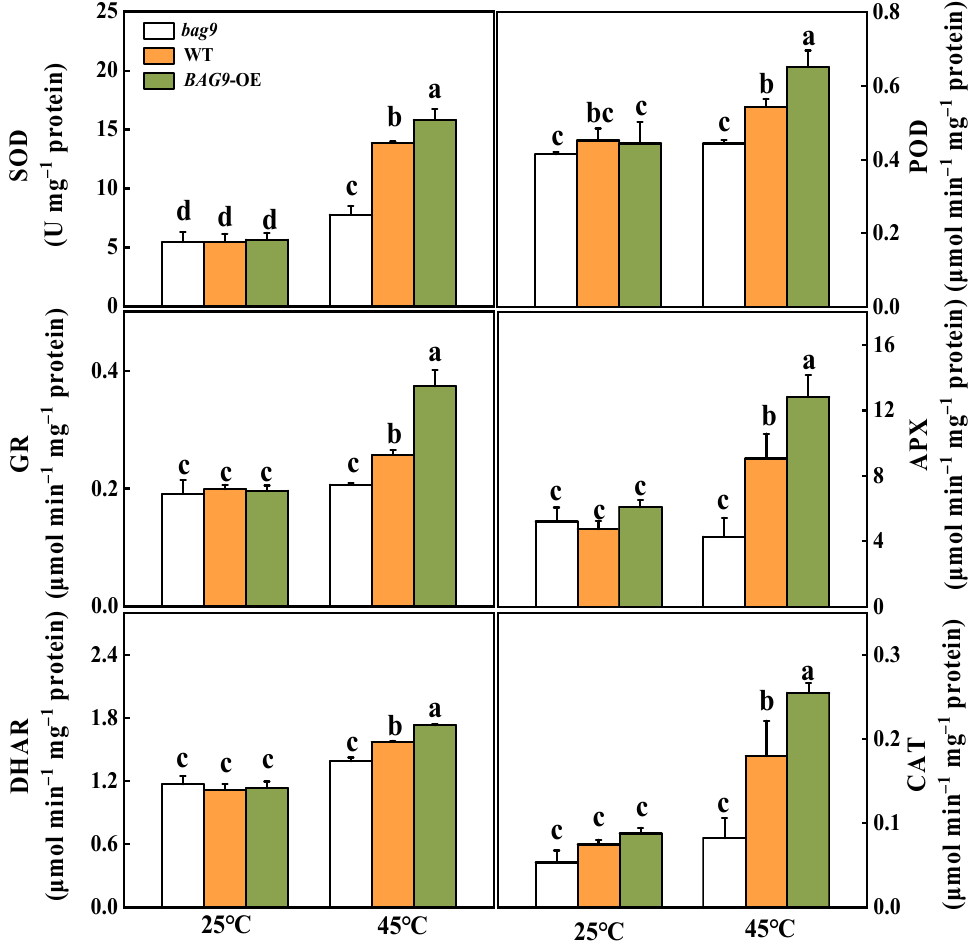
Figure 5. Activities of SOD, POD, APX, GR, CAT, and DHAR with or without heat stress in tomato leaves. Data were the means ± SD of three biological replicates. Different letters represented significant differences ( p < 0.05) according to Tukey’s test. WT, wild type; BAG9 -OE, BAG9 overexpressing plants.